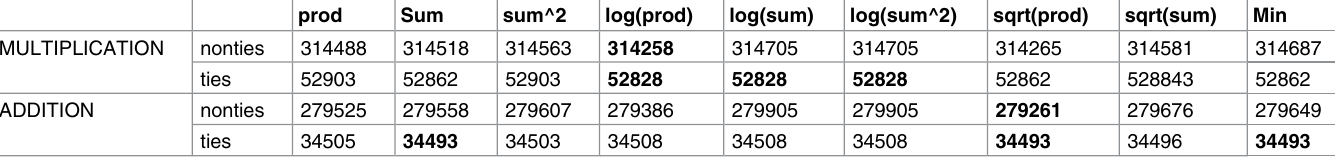
Table 2. Linear mixed effects analysis for RTs for addition and multiplication and for tie and nontie problems, using eight different regressors: the product of the operands (prod), the sum of the operands (sum), its sum squared (sum^2), these three regressorsin log scale (log(prod), log(sum), and log(sum^2)), the square root of its products (sqrt(prod)) and its sums (sqrt(sum)), and the min operand. Bold letters indicatebest fit, i.e. minimum AIC value. Observe that in the tie cases, the min, sqrt(prod) and sum regressors represent the same